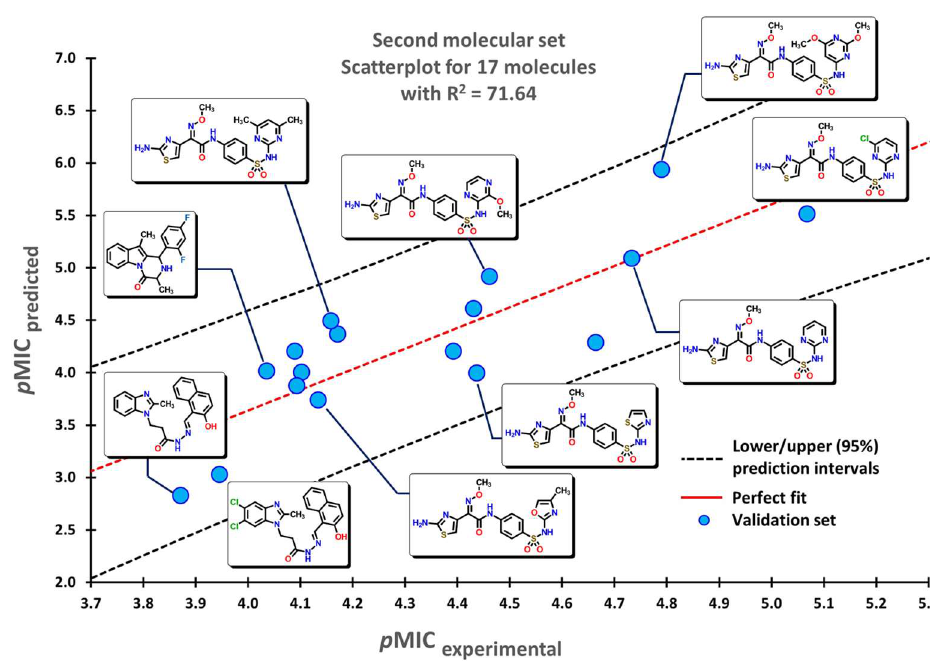
Figure 5. Scatterplots for the molecular data set were used for the validation of the QSPR model. Selected molecules are displayed within the plots.